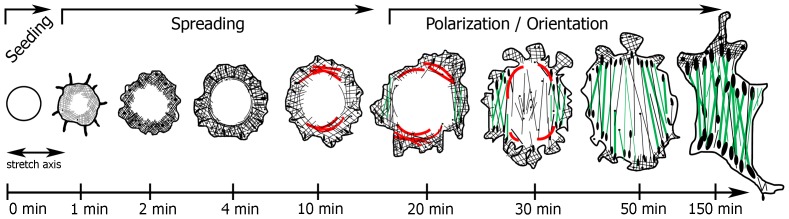
Overview of cell spreading and orientation under cyclic stretch conditions.Spreading of fibroblasts upon CTS application occurs in two phases. In the first phase (“Spreading”) the initial cell attachment is generated. Then a circular lamellipodia and dot-like cell-matrix adhesion sites are visible. The cell reaches its critical adhesive area. In the beginning of the second phase (“Polarization/Orientation”) the cell adhesive area reaches its maximum and cell elongation is initiated. The cell develops with increasing time of stretching pronounced actin stress fibers and cell-matrix adhesions which become with time perpendicularly oriented with respect to the stretch axis. In the spreading phase the formation of actin bundles in parallel to the stretch axis is observed while cell-matrix adhesions emerged homogenously distributed along the cell edges independently of the stretch direction. Cell-matrix adhesions sites reoriented into a perpendicular alignment and the parallel actin fibers realign into a perpendicular orientation and partially disassemble as the stretching force continues to act on the cell.